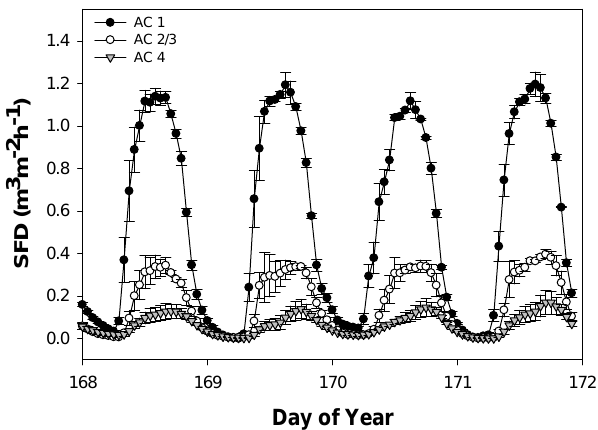
Figure 1. Sap flux density (SFD) of Fraxinus pennsylvanica trees during 26–30 June 2010 (AC1 = low infestation levels, AC 2 & 3 moderate infestation levels, and AC4 = high infestation levels). Error bars denote ±1 SE.